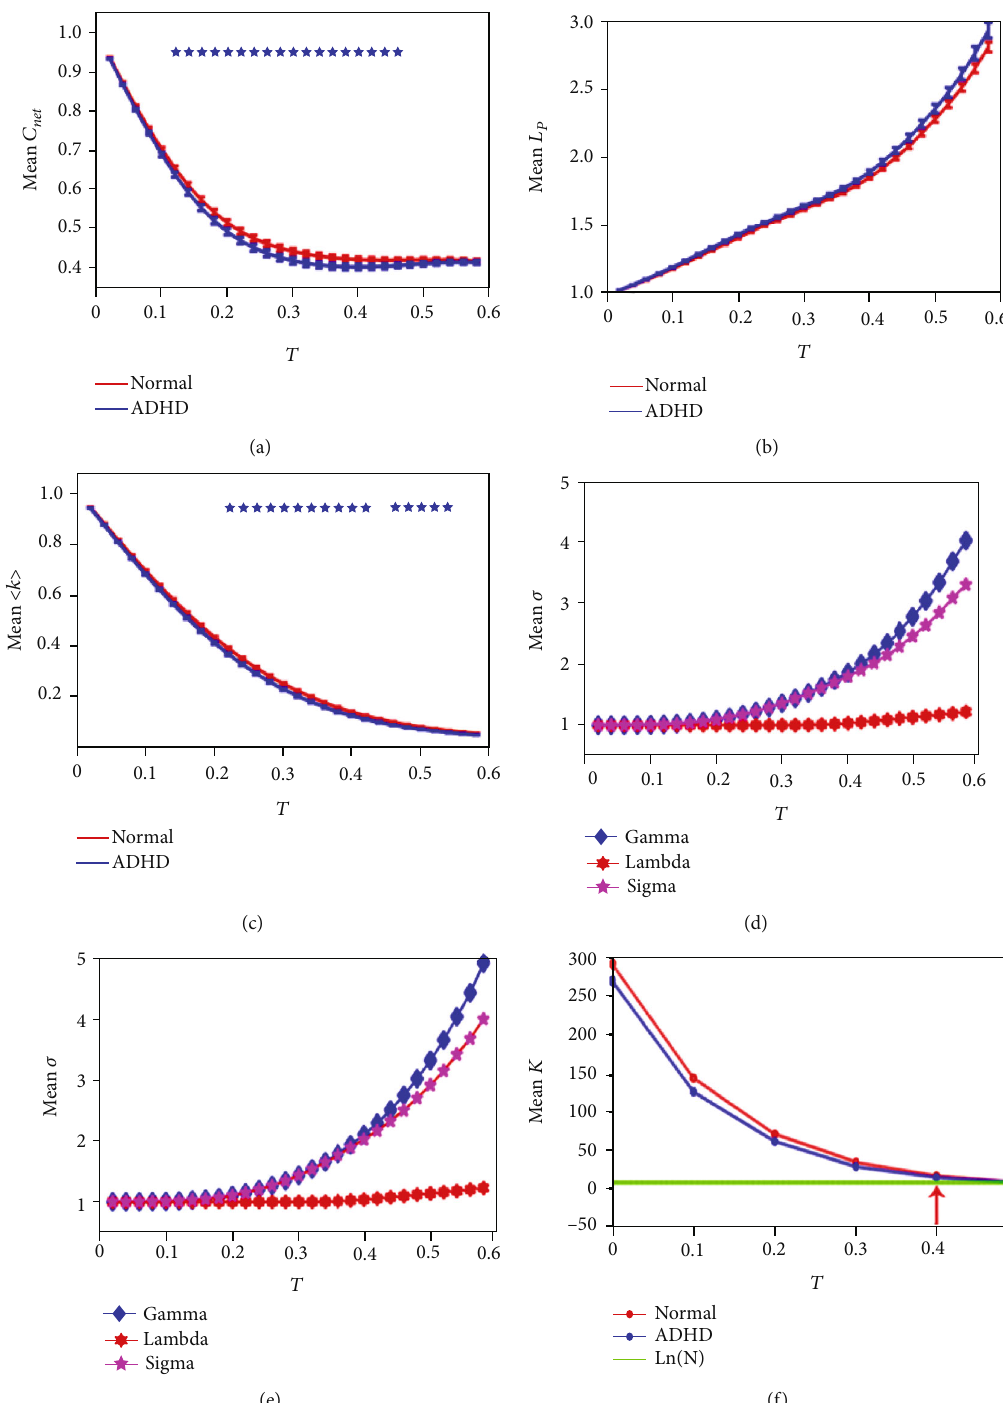
Figure 2: Changes of the network properties of the two groups within the threshold: (a) the average clustering coe ffi cient (mean C ) of the net ) of two groups; (c) the average node degree with normalization (mean < k > ) of two groups; (b) the average shortest path length (mean L p the two groups; (d) small-world network properties (mean σ ) of the normal group; (e) small-world network properties (mean σ ) of the ADHD group; (f) the average node degree (mean k , < k > ) of the two groups. Blue represented the ADHD group, and red represented the normal group; the blue asterisk represented statistical signi fi cance ( p < 0 : 05 , Bonferroni correction), and green represented Ln ð N Þ ; N was the number of network